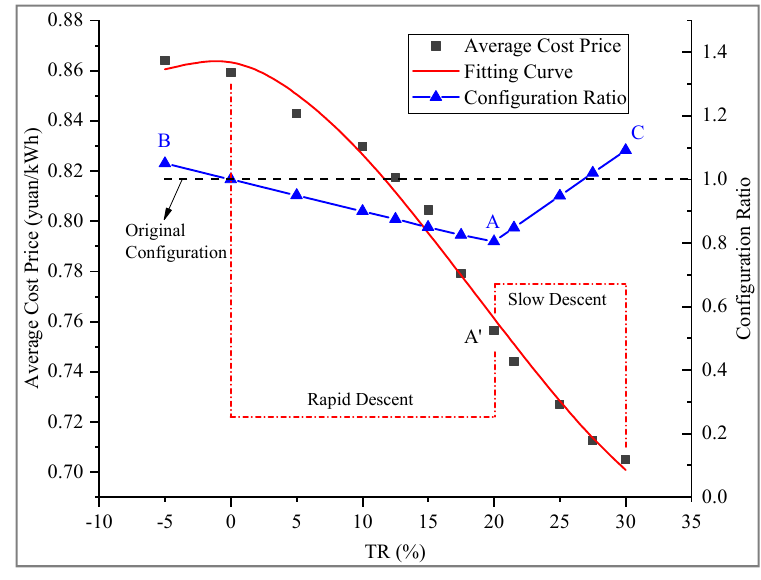
Figure 8. Electricity cost price curves for the 12 different load profiles.